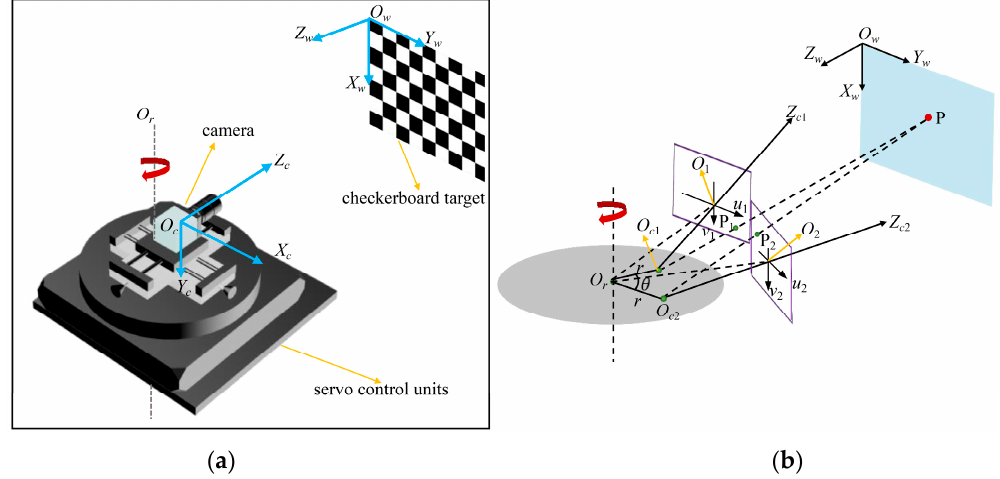
Figure 1. ( a ) Schematic diagram of the rotating optical measurement system; ( b ) schematic diagram of the imaging model.